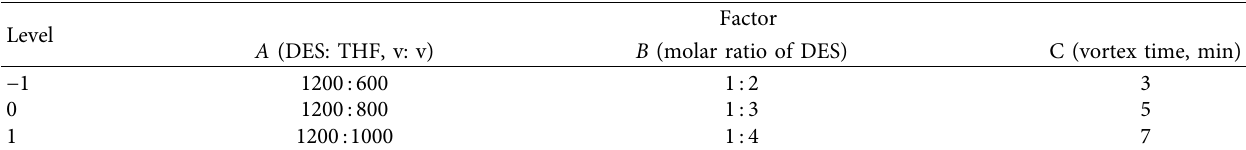
Figure 3: Effects of various factors on the extraction rate of palmatine, berberine, and baicalein in SD. (a) Effect of the molar ratio of DES, (b) effect of the DES volume, (c) effect of the THF volume, and (d) effect of the vortex time. Table 5: Response surface optimization